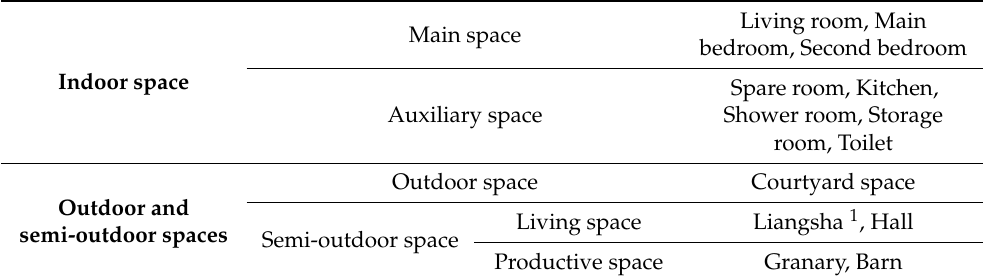
Table 6. Space classification of vernacular dwellings in